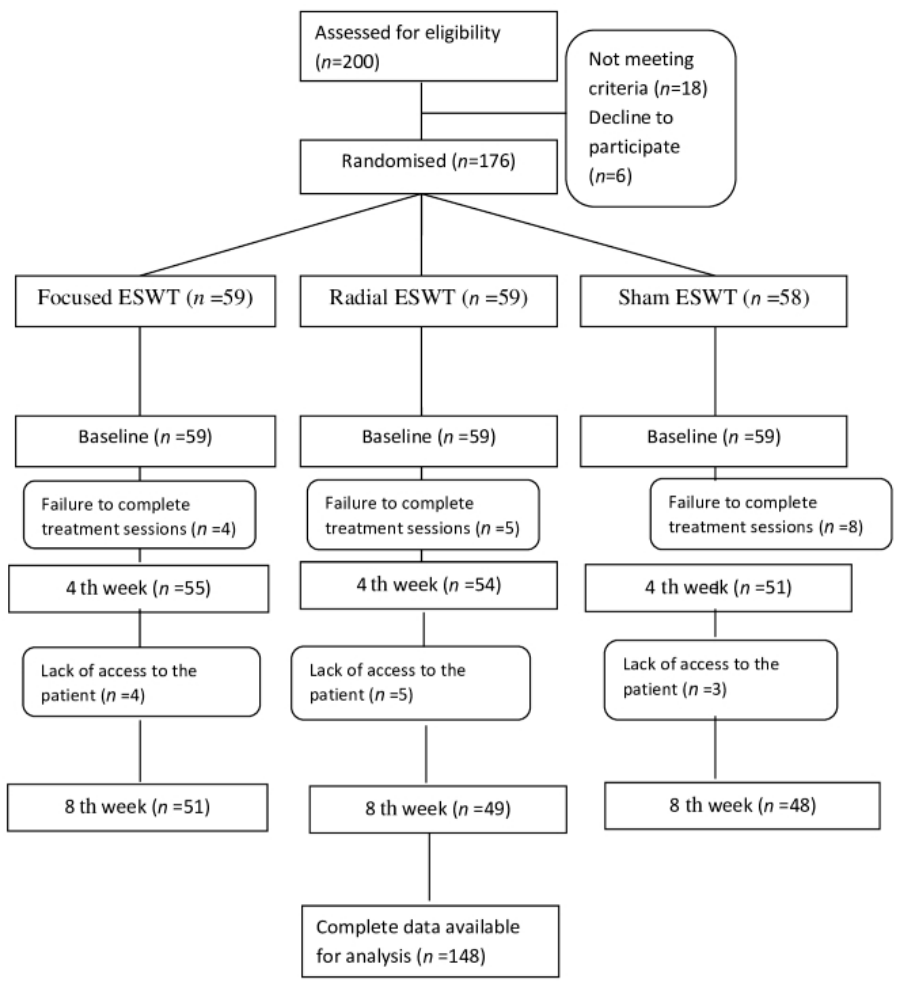
Figure 1. Flowchart of the study participants.